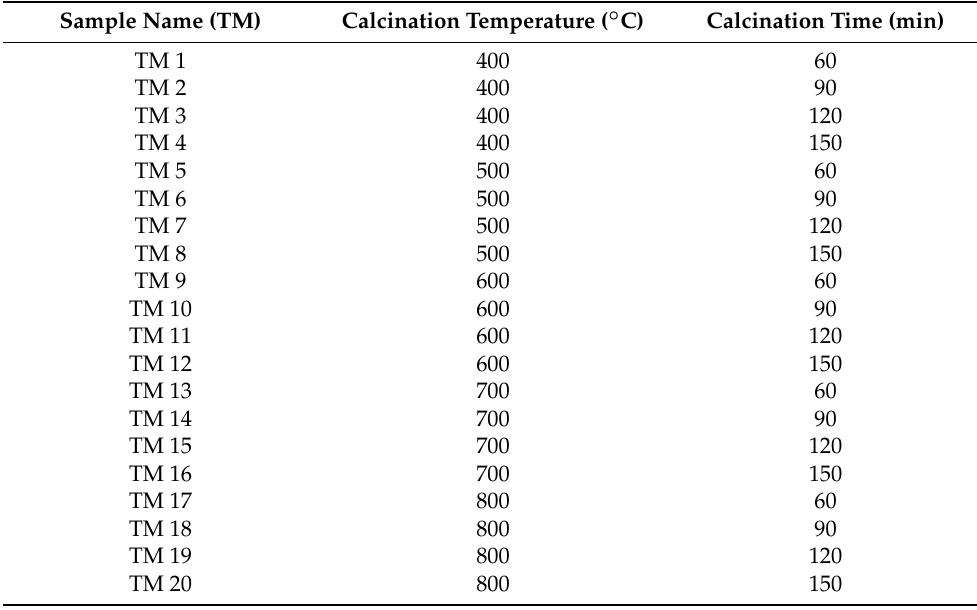
Table 3. Thermal activation parameters of copper-mine